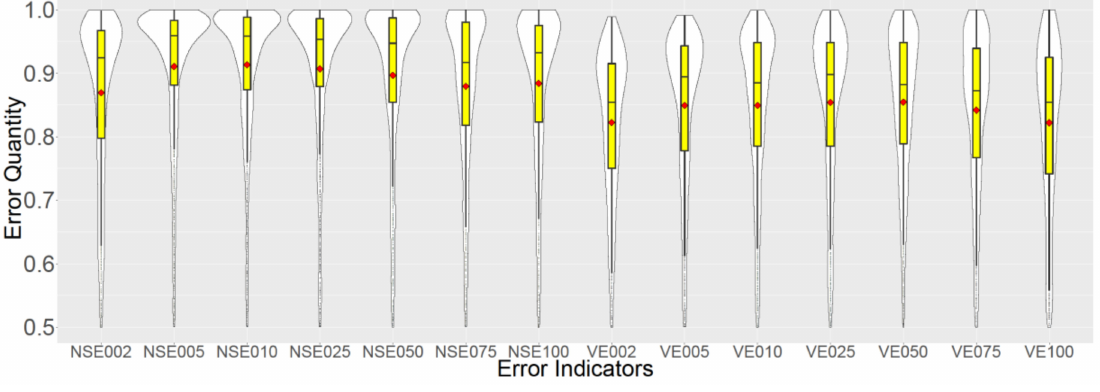
Figure 7. Effect of reducing the training dataset size on distribution of emulation error indicators NSE ( left ) and VE ( right ) for validation dataset (e.g., NSE075 indicates NSE distribution when 75% of the training data is used to train the emulator). Red square shows the mean